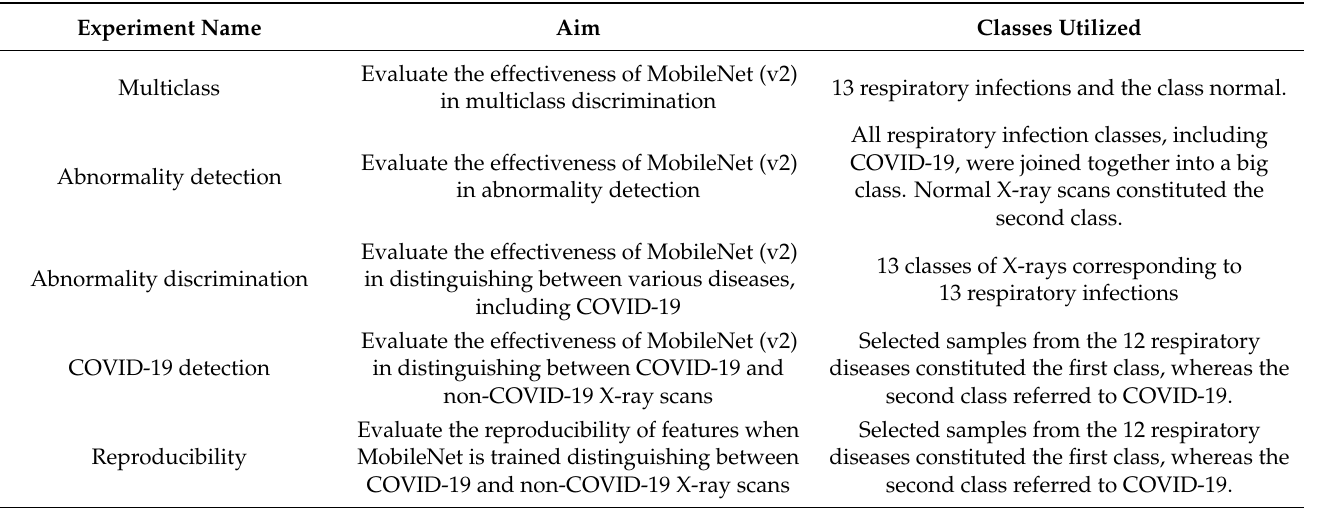
Table 2. Overview of the experiments.